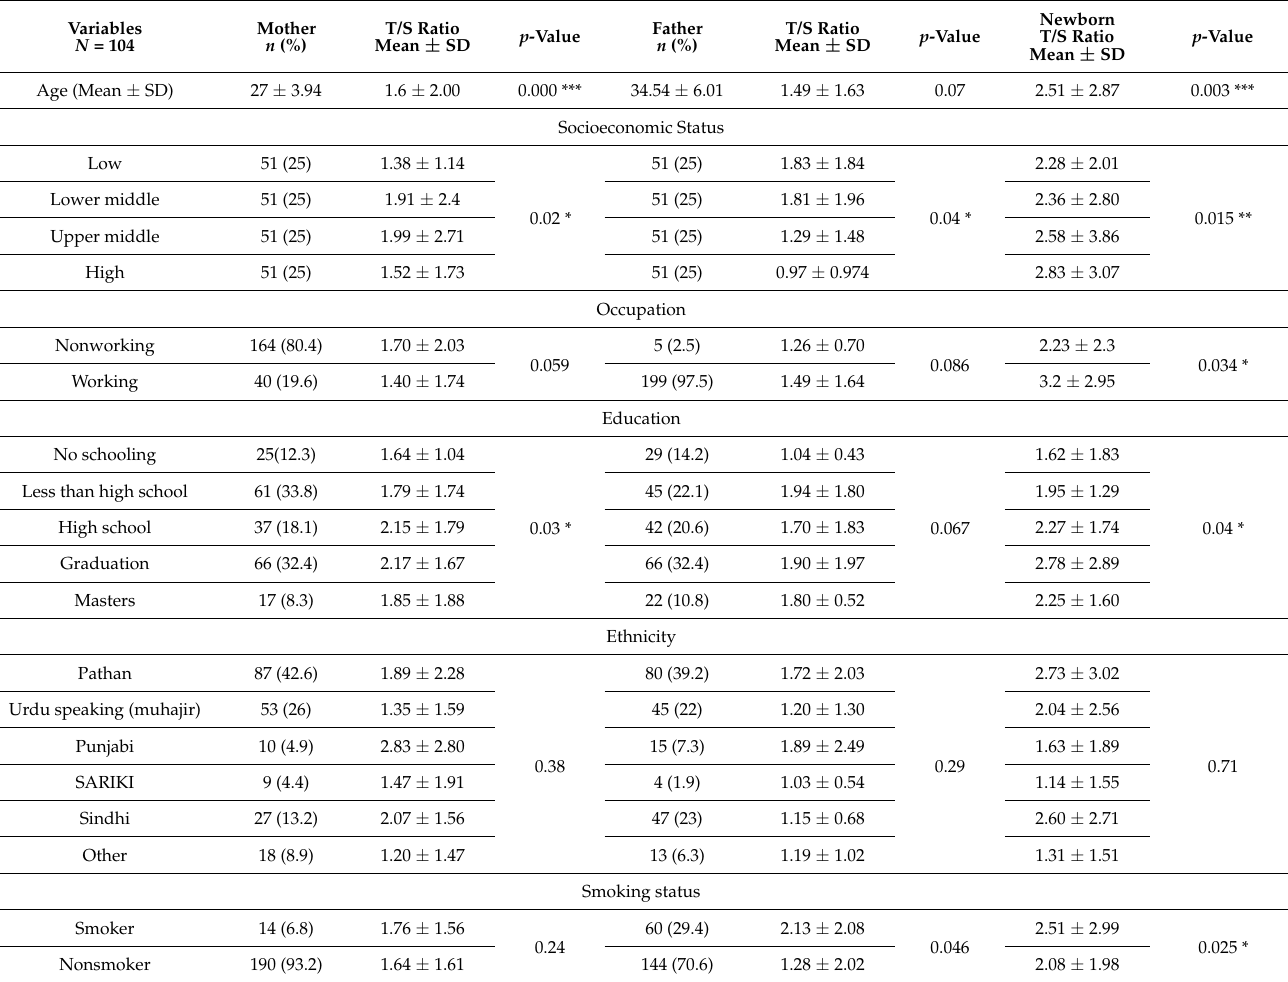
Table 1. Comparison between mother, father, and newborn telomere length among different